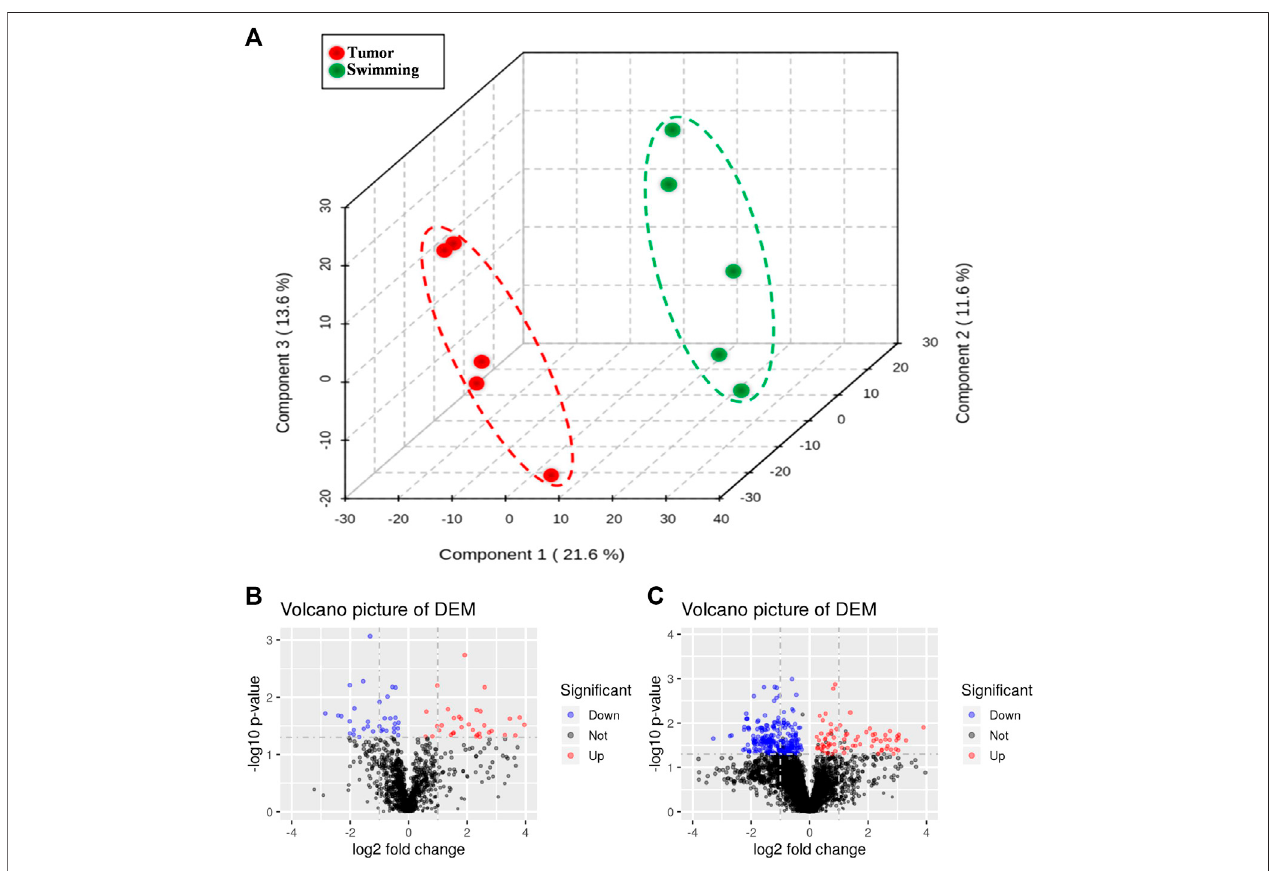
FIGURE 7 | Changes in metabolic pro fi ling after regular swimming training. (A) PCA plot was obtained by reduction of dimensionality for LC-MS data of Tumor group and Swimming group (explained variance byComponent1 21.6%, Component211.6% and Component3 13.6%). Thered circle shows the distribution ofTumor group in PCA plot, while the green one displays the location of Swimming group. Distance represents the difference between two groups. Volcano plots of differential metabolitescreeningbetweentheTumorgroupandtheSwimminggroupatboth (B) positiveand (C) negativeionmodes.Theblueandreddotsrespectivelymark down-regulated and up-regulated metabolites after swimming training, whereas the black ones represent no differences between the two groups.